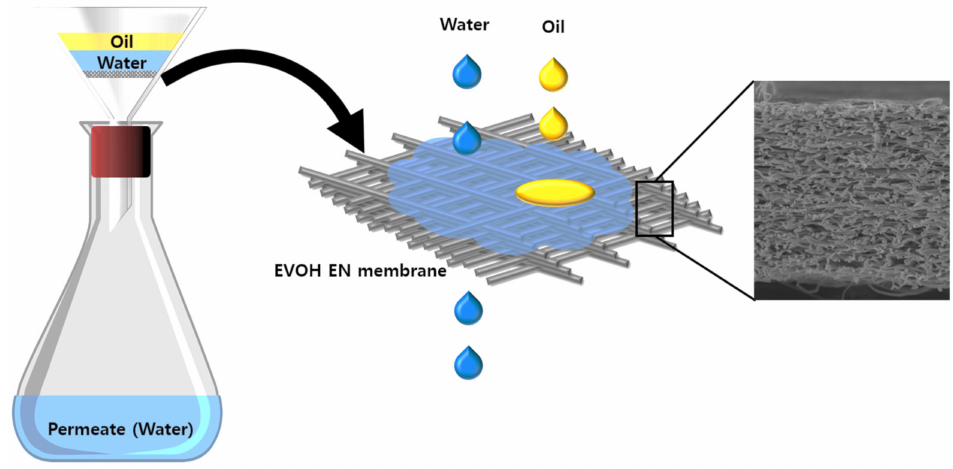
Figure 1. Schematic diagram of the oil/water separation